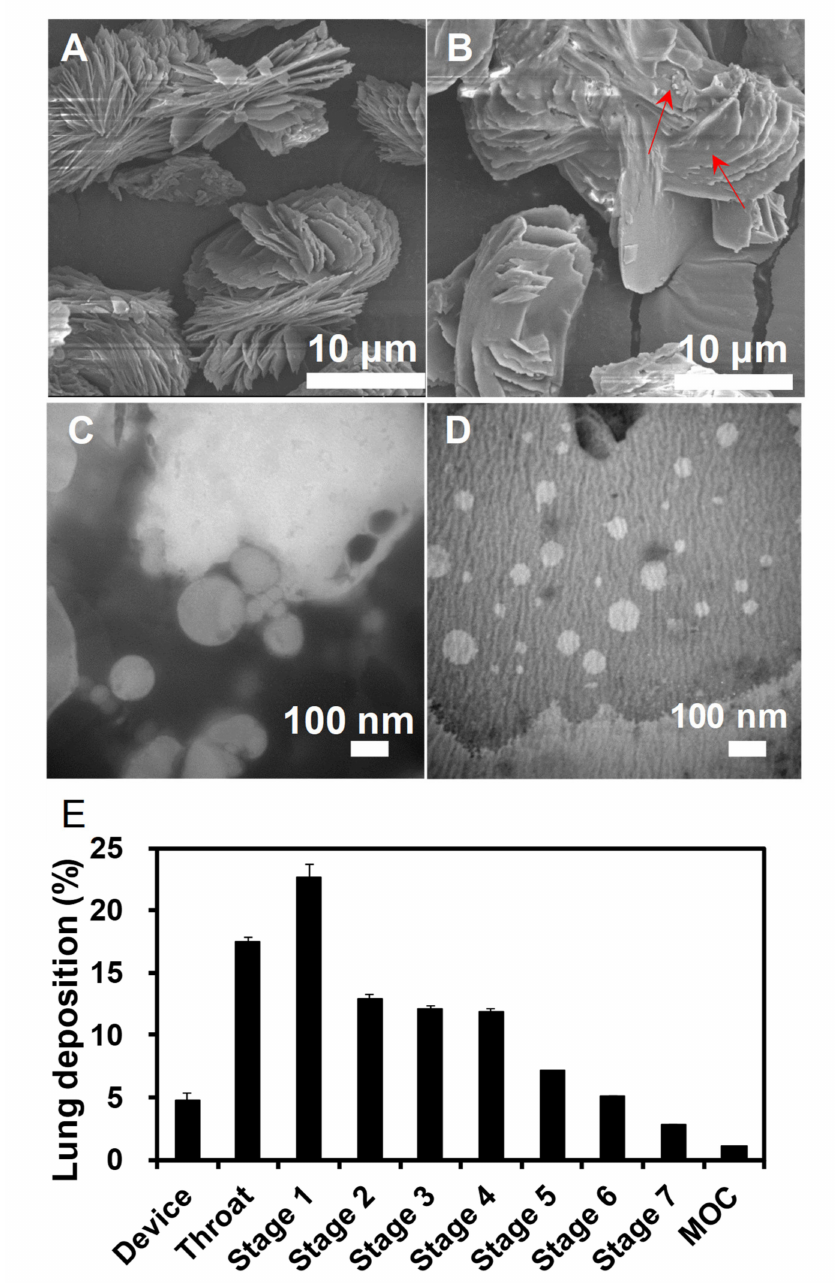
Figure 1. SEM images of blank excipients ( A ) and jojoba oil (JJBO) dry nanoemulsion powders (JNDs) ( B ). TEM images of the original JJBO nanoemulsions (JNEs) ( C ) and the JNEs reconstituted from JNDs ( D ). JJBO in the JNDs depositing in the Next Generation Impactor (NGI) ( E ). The data are presented as means ± SD ( n = 3). The arrows indicate the JNE